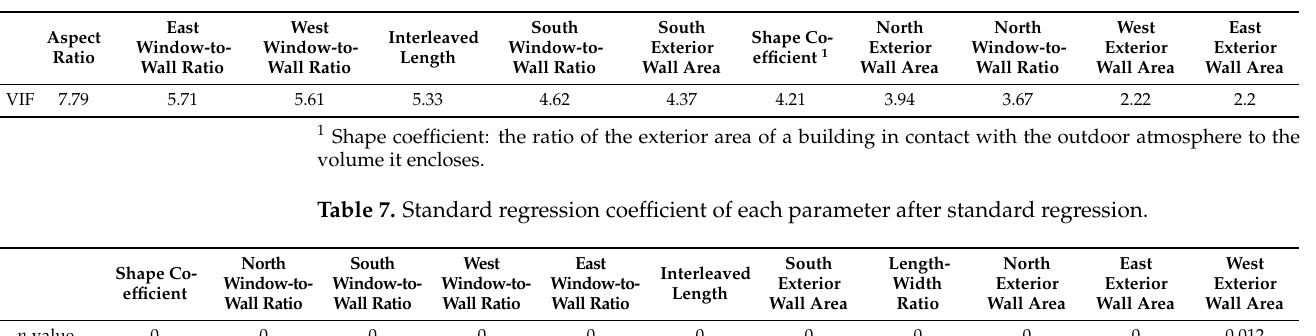
Table 6. VIF value of each parameter.